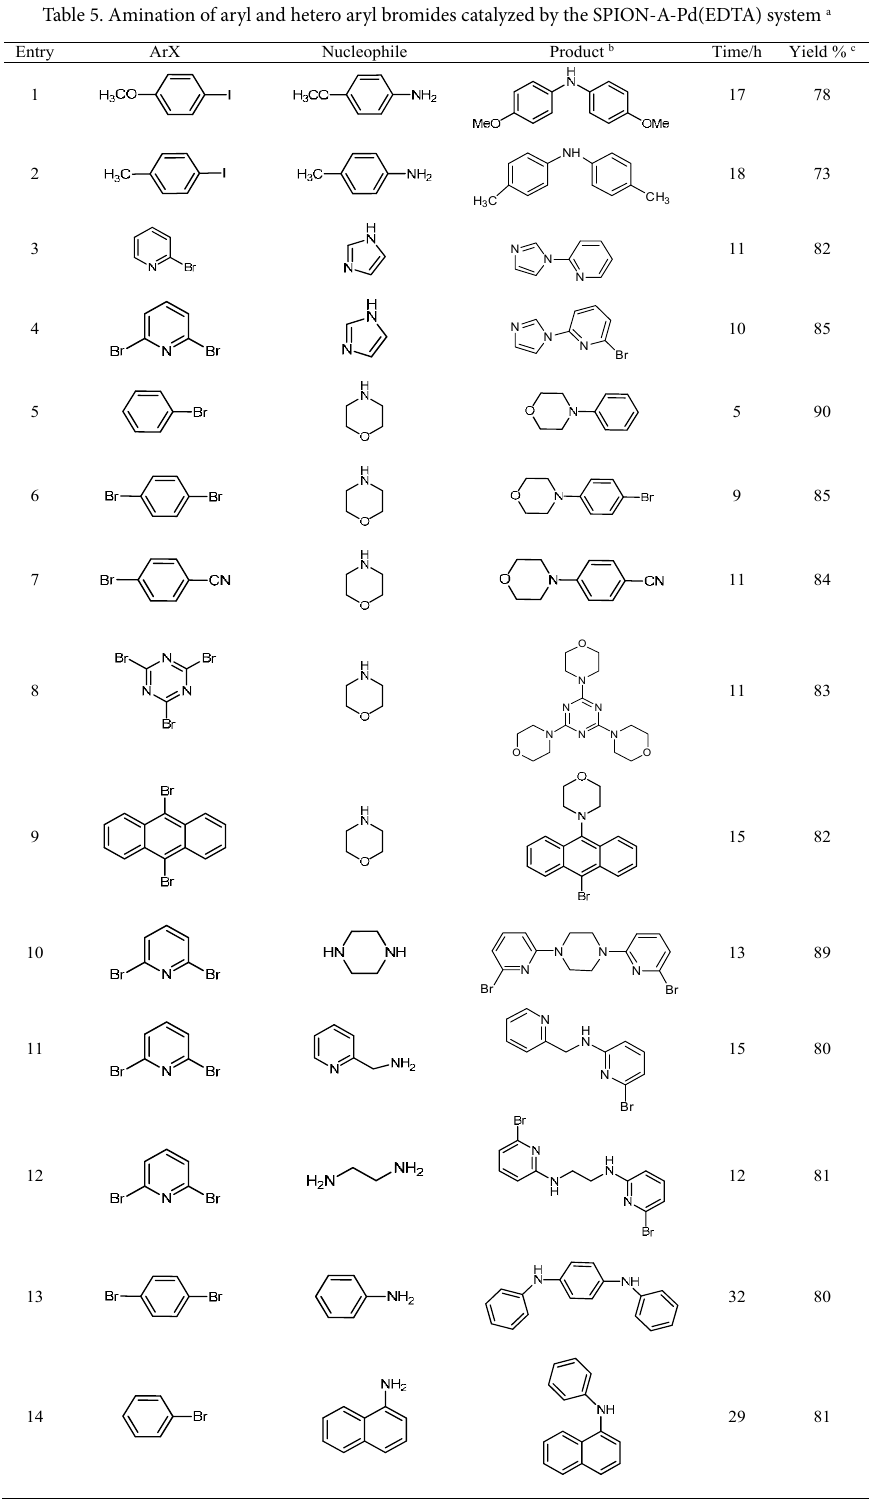
Table 5. Amination of aryl and hetero aryl bromides catalyzed by the SPION-A-Pd(EDTA) system